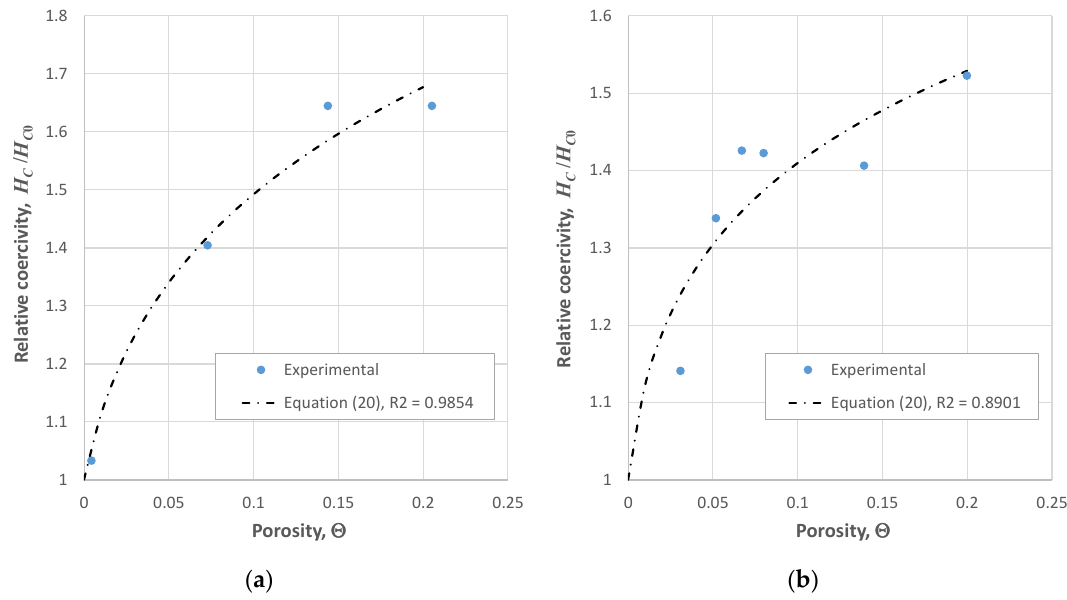
Figure 7. Alternative behaviour of the coercivity vs. porosity according to: ( a ) Lenel [99] and ( b ) Jiles et al. [92], and fitting with the Equation (20).